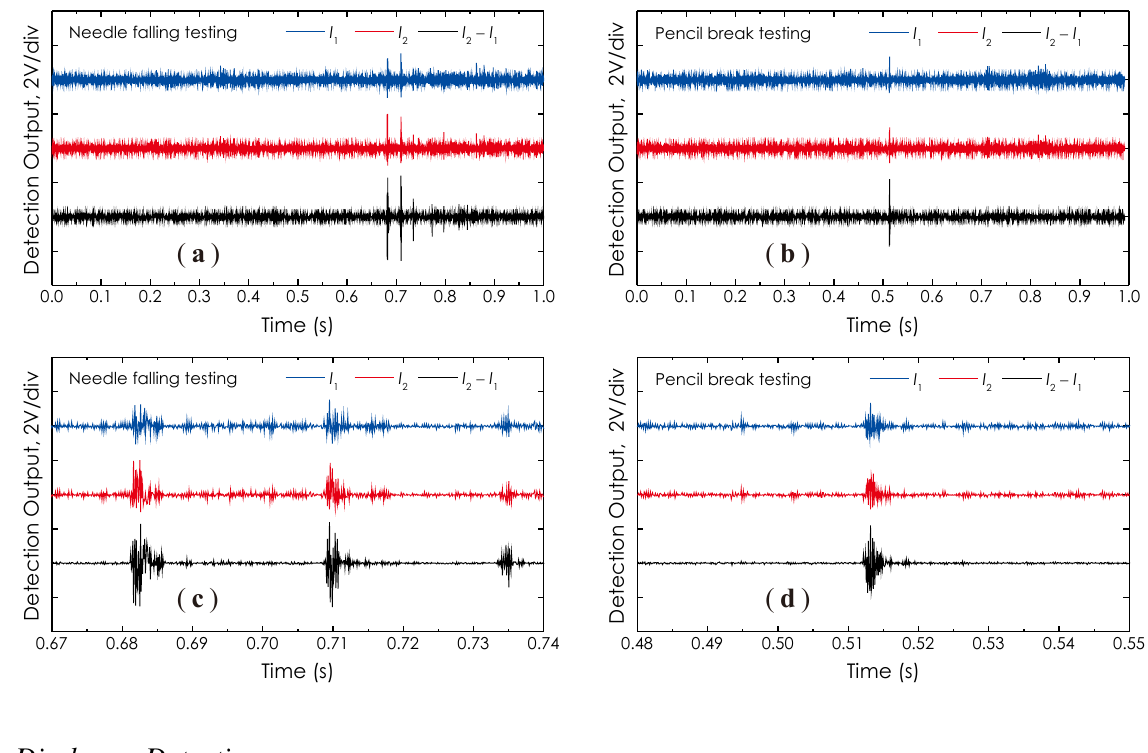
Figure 15. Measured waveforms from: ( a ) needle falling; and ( b ) pencil lead breaking. ( c , d ) Two corresponding enlarged